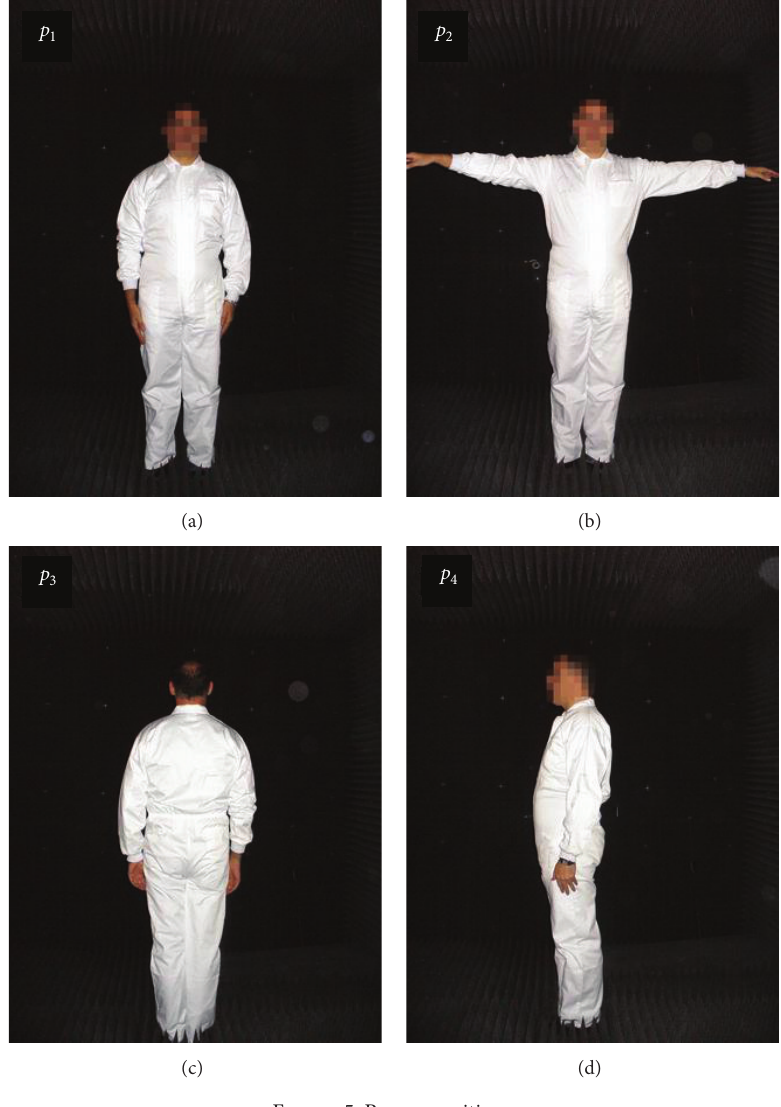
Figure 5: Person